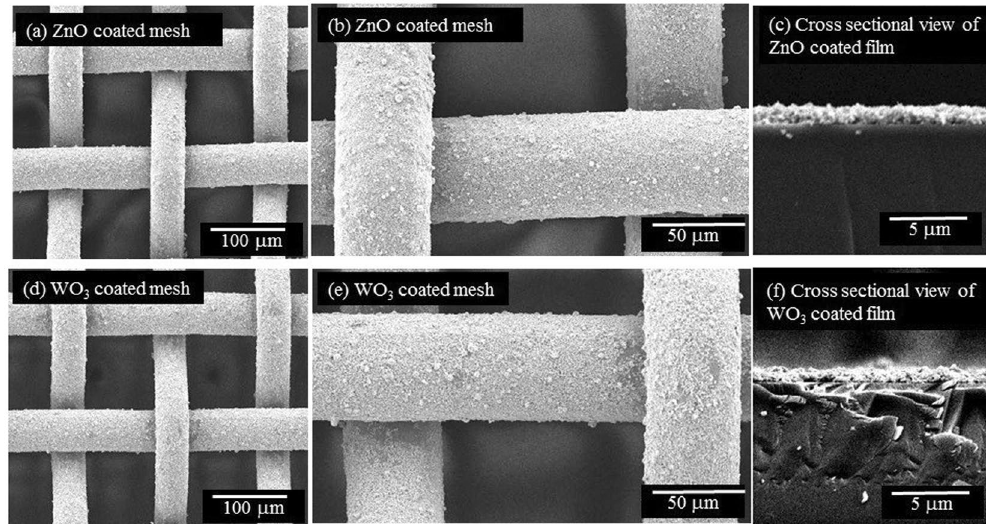
Figure 1. SEM image of coated stainless steel mesh with the pore size of 100 µ m, ZnO coated mesh at ( a ) 200 X ( b ) 500 X magnification and ( c ) cross sectional view of ZnO film at 4000 X magnification. WO 3 coated mesh at ( d ) 200 X ( e ) 500 X magnification and ( f ) cross sectional view of WO 3 film at 4000 X magnification. Both and WO 3 and ZnO coated surfaces have a uniformly distributed granular structure with micro and nanoscale hierarchical roughness and free from agglomeration. The cross sectional views further clarify the uniform distribution of the nano particles with the average thickness of 1 to 2